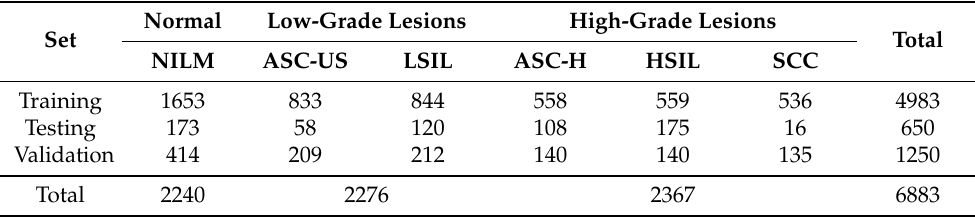
Table 3. The numbers of images from each class after balancing and data augmentation for the training, validation, and testing sets in the three-class classification.